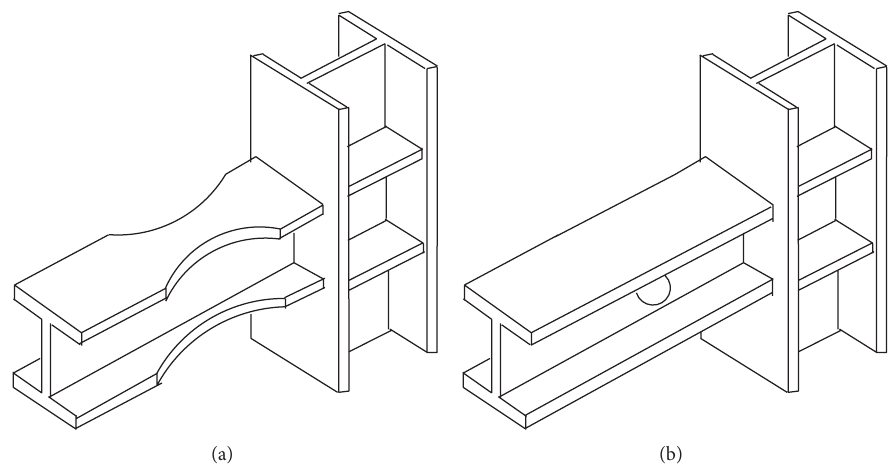
Figure 1: (a) Flange slab weakened steel connection and (b) web plate groove weakened steel connection.